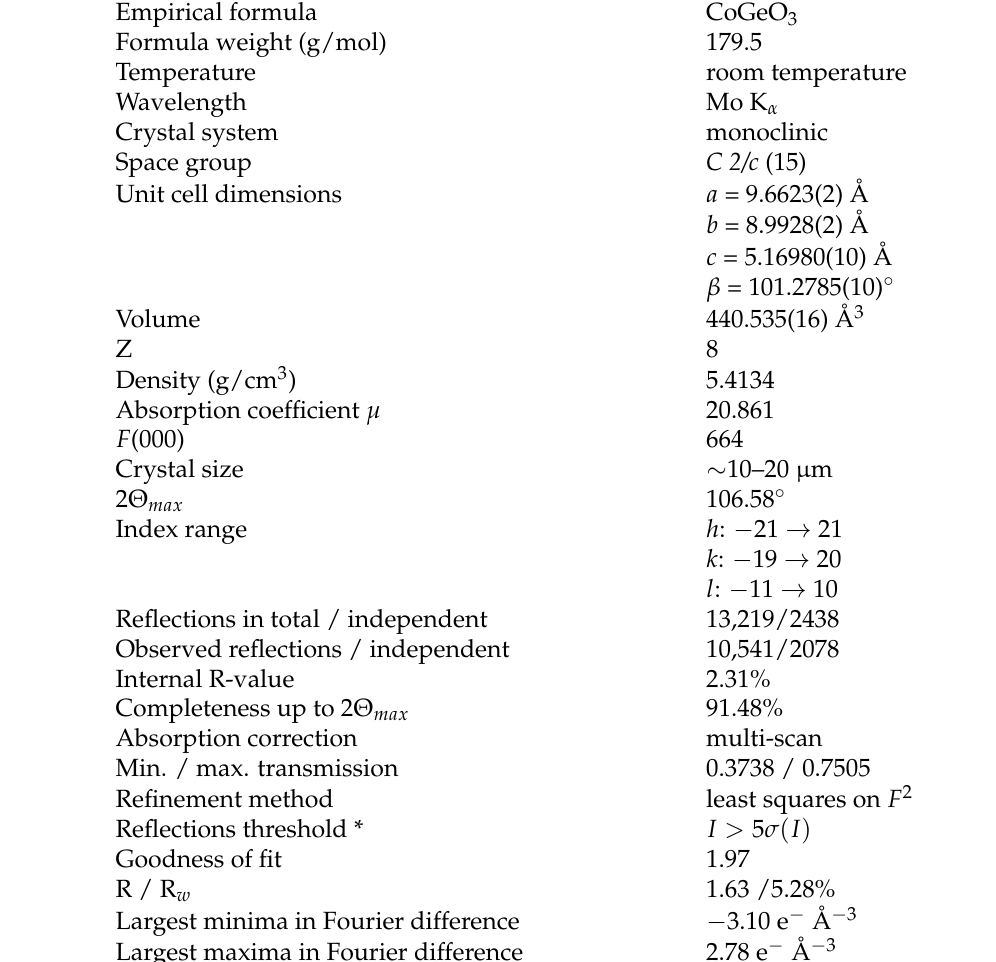
Table 1. Crystallographic and structural refinement data of a single crystal X-ray diffraction mea- surement. The crystallographic software Jana was used for the structural refinement [15]. The lattice parameters were obtained from a powder X-ray diffraction measurement using Cu K α 1 radiation (Rietveld refinement with Fullprof [16]; χ 2 = 2.24). [*: unobserved reflections were also used.]